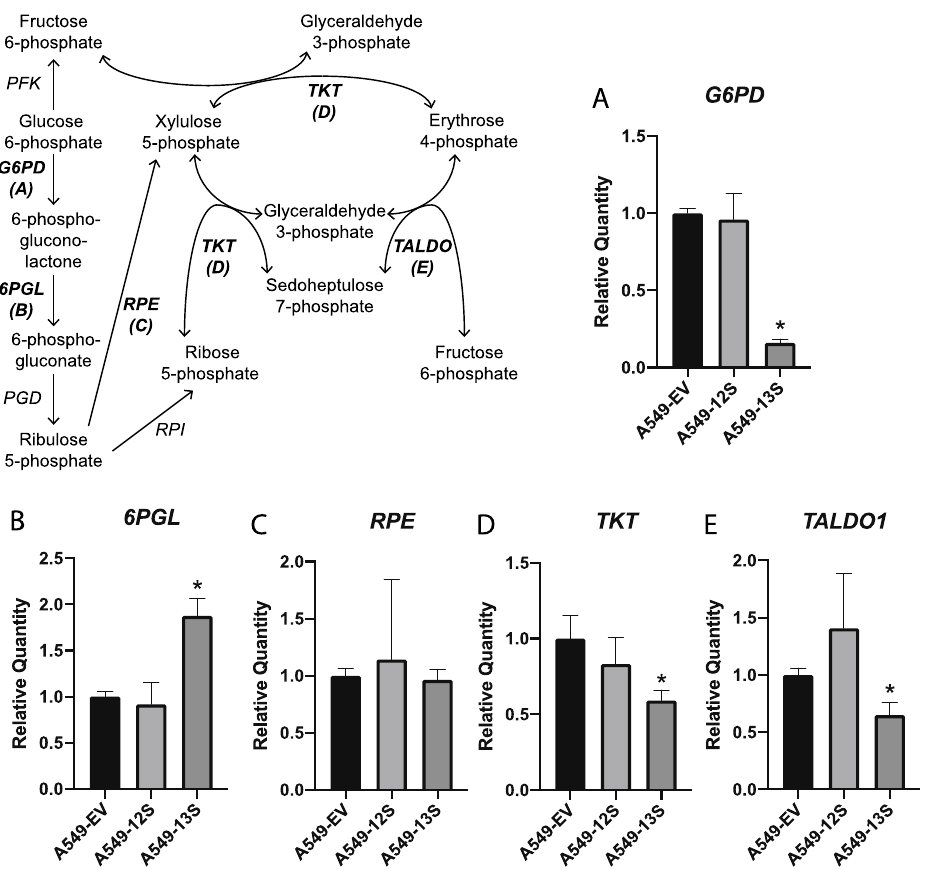
Figure 3. Relative expression of mRNA for pentose phosphate pathway genes in 13S and 12S expressing A549 cells. The mRNA expression for five genes encoding components of the pentose phosphate pathway were measured with qPCR ( A – E ). The pentose phosphate pathway relies on the products of glycolysis. Only the A549-13S cells displayed differential regulation of transcripts in this pathway. Of the five pentose phosphate pathway genes measured, three were downregulated ( A , D , E ) and one was upregulated in the A549-13S cells ( B ). H2AFY was used as a reference gene. Asterisks (*) indicate p < 0.05. n = three per group for all panels. G6PD , Glucose-6-phosphate dehydrogenase; 6PGL , 6-phosphogluconolactonase; PGD , Phosphogluconate dehydrogenase; RPE , Ribulose-5-phosphate-3-epimerase; RPI , Ribose 5-phosphate isomerase; TKT , Transketolase; TALDO , Transaldolase; PFK , Phosphofructokinase.